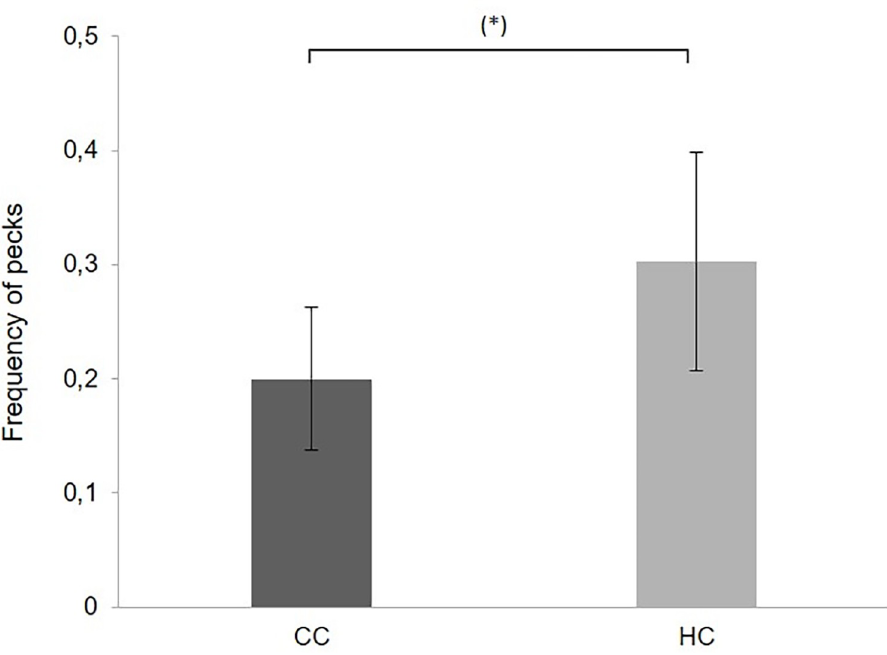
Fig 3. Severe feather pecking and pecks (nrs of pecks per minute per group ( ± SEM), in chicks from a commercial hatchery (HC) and control chicks (CC) at 15 w of age, ( � ) p < 0.1.